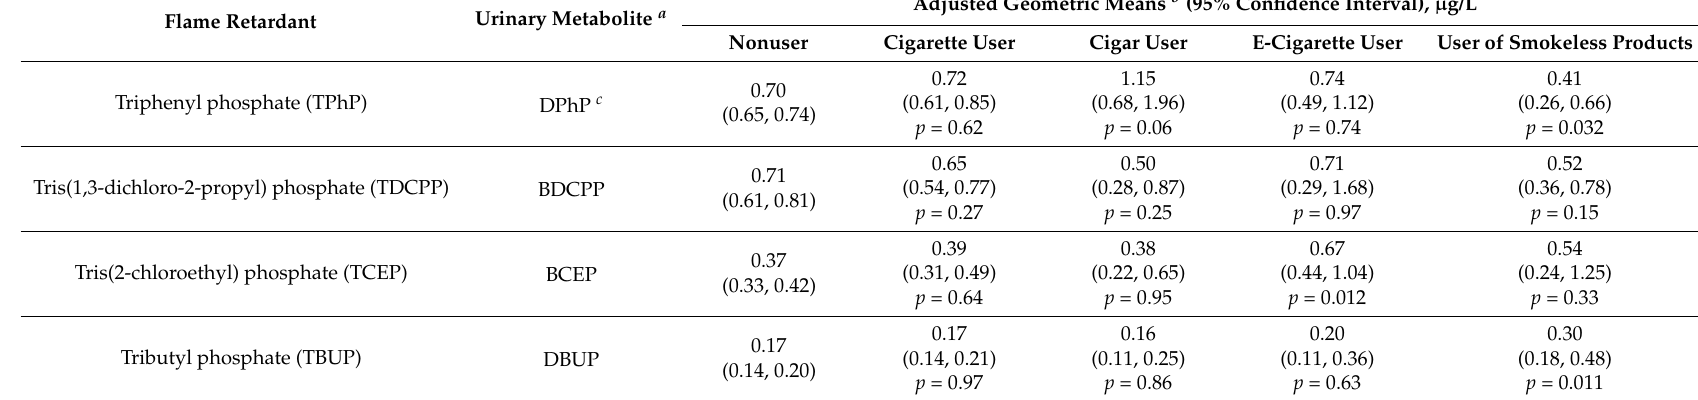
Table 4. Adjusted geometric means of FR metabolites among different tobacco user categories and